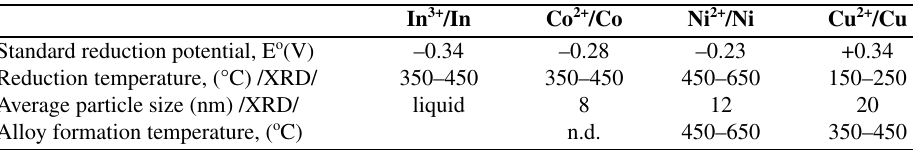
Table 1. Formation of active metal components in H